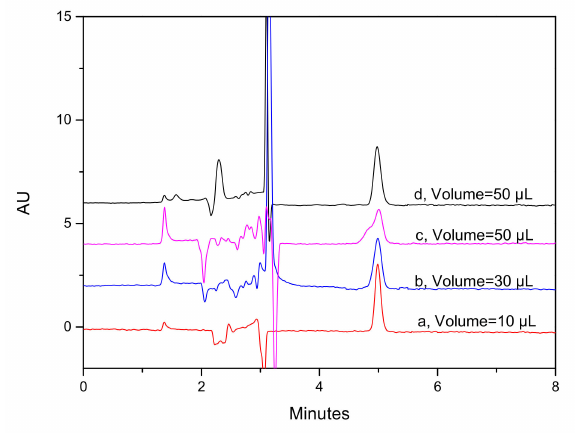
Figure 3. The chromatogram of astilbin in 75% methanol with di ff erent injection volumes (a, b, c) and in 40% methanol with 50 µ L of injection volume (d).